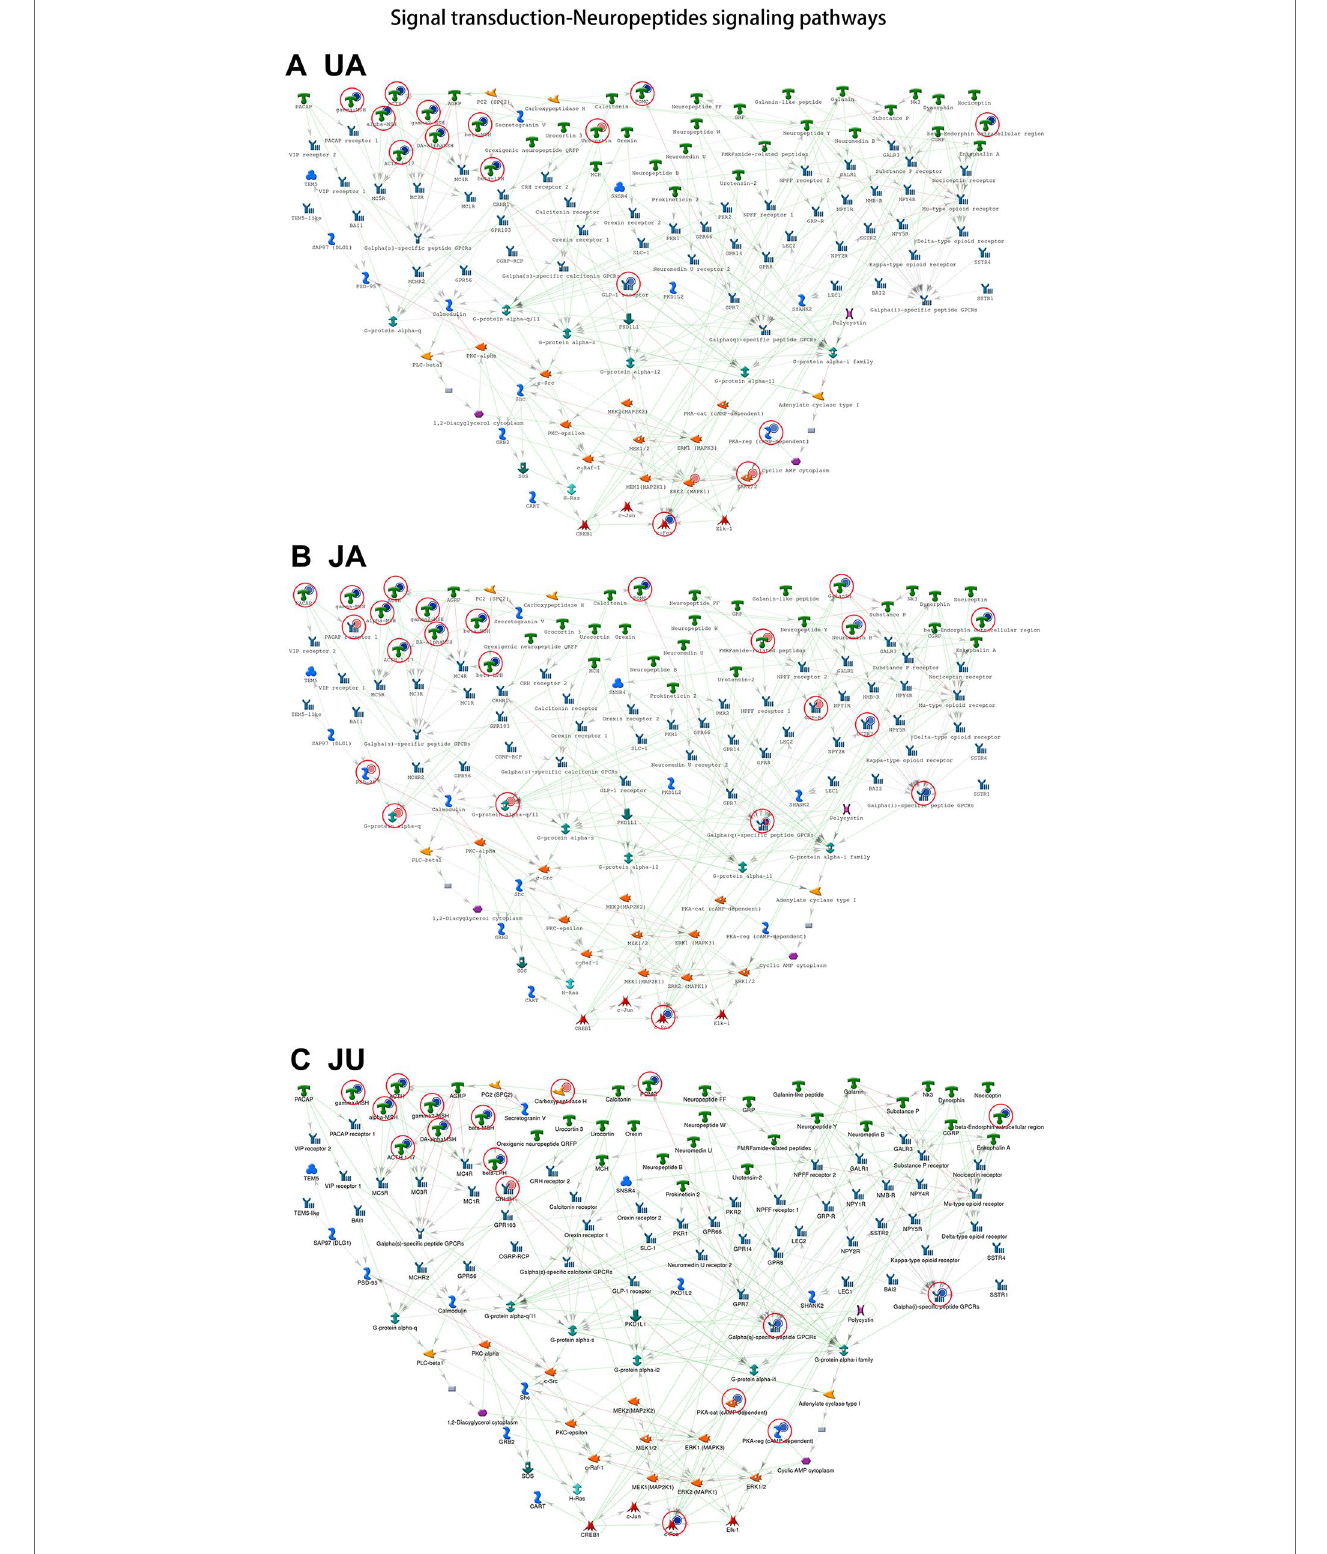
FIGURe 5 | The common process of treatment groups. Signal transduction-neuropeptides signaling pathways. (A) Ursodeoxycholic acid group. (B) Jasminoidin group. (C) JA and UA combination group.